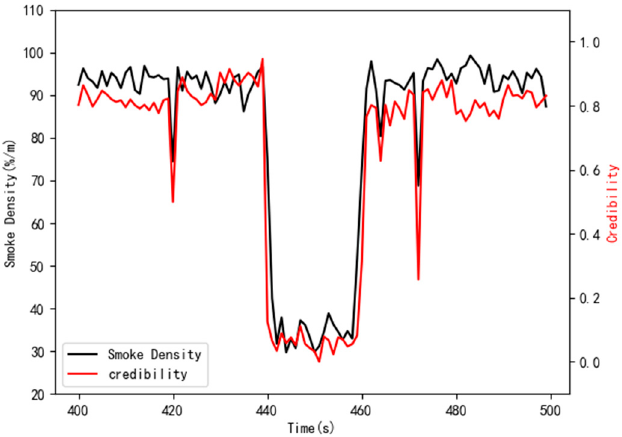
Figure 13. Assessment results of comprehensive data credibility.